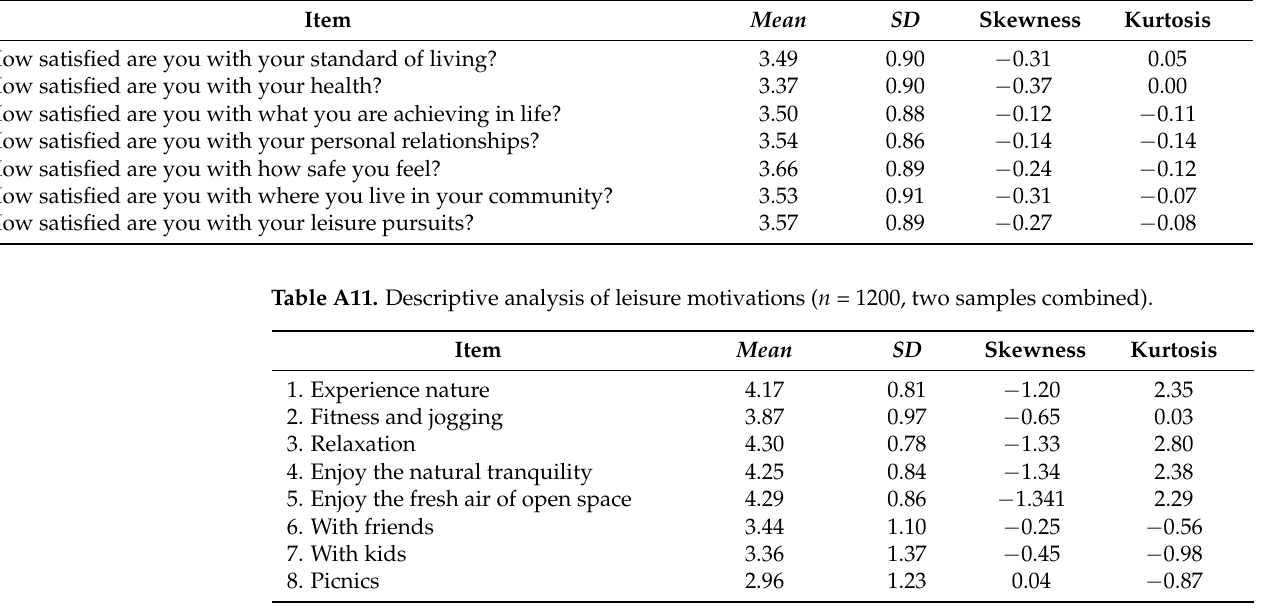
Table A12. Descriptive analysis of the New Ecological Paradigm ( n = 1200, two samples